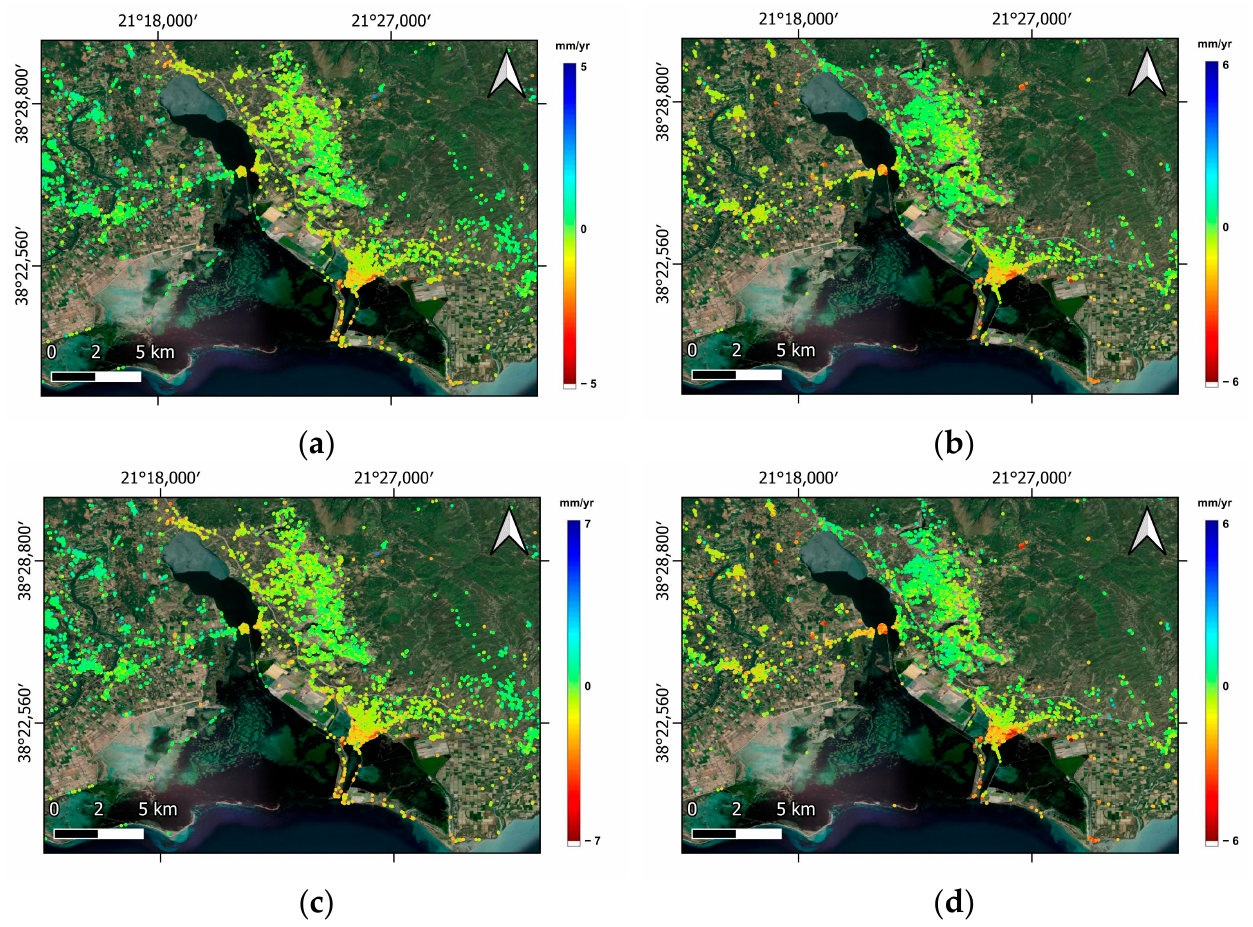
Figure 8. LOS displacements for the broader area of ( a ) the descending satellite pass (no. 80) ( b ) for the ascending satellite pass (no. 175). Vertical displacements for the broader area of ( c ) the descending satellite pass (no. 80) ( d ) for the ascending satellite pass (no. 175). All figures were derived from the P-PSI satellite data analysis conducted at BEYOND.